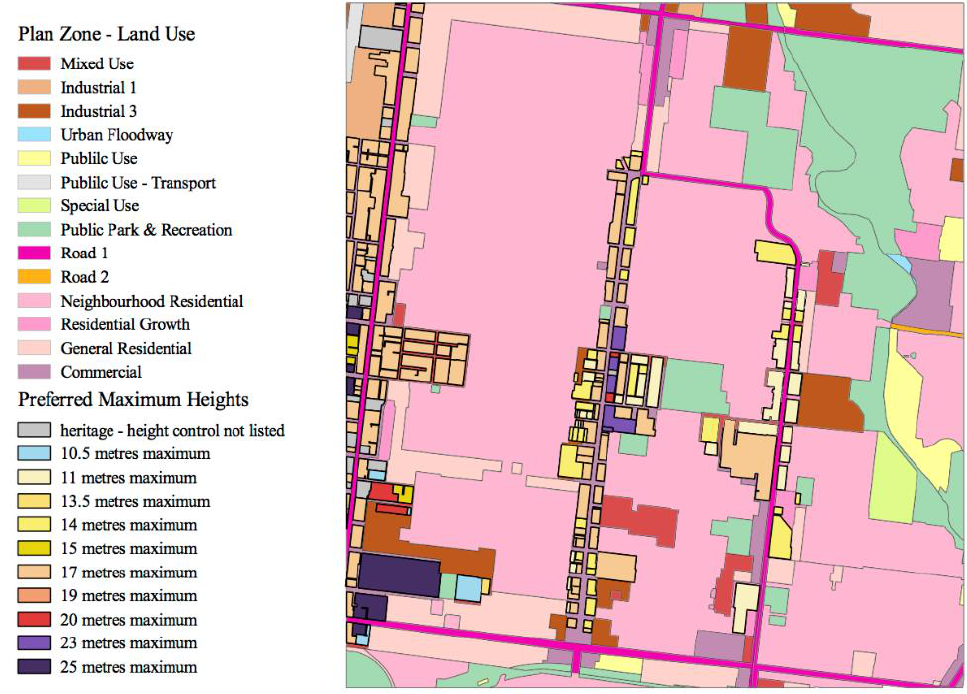
Figure 4. Merging ‘Plan_Zone’ with ‘LocalScheme’ from Figure 1 to create ‘SchemeControls’.